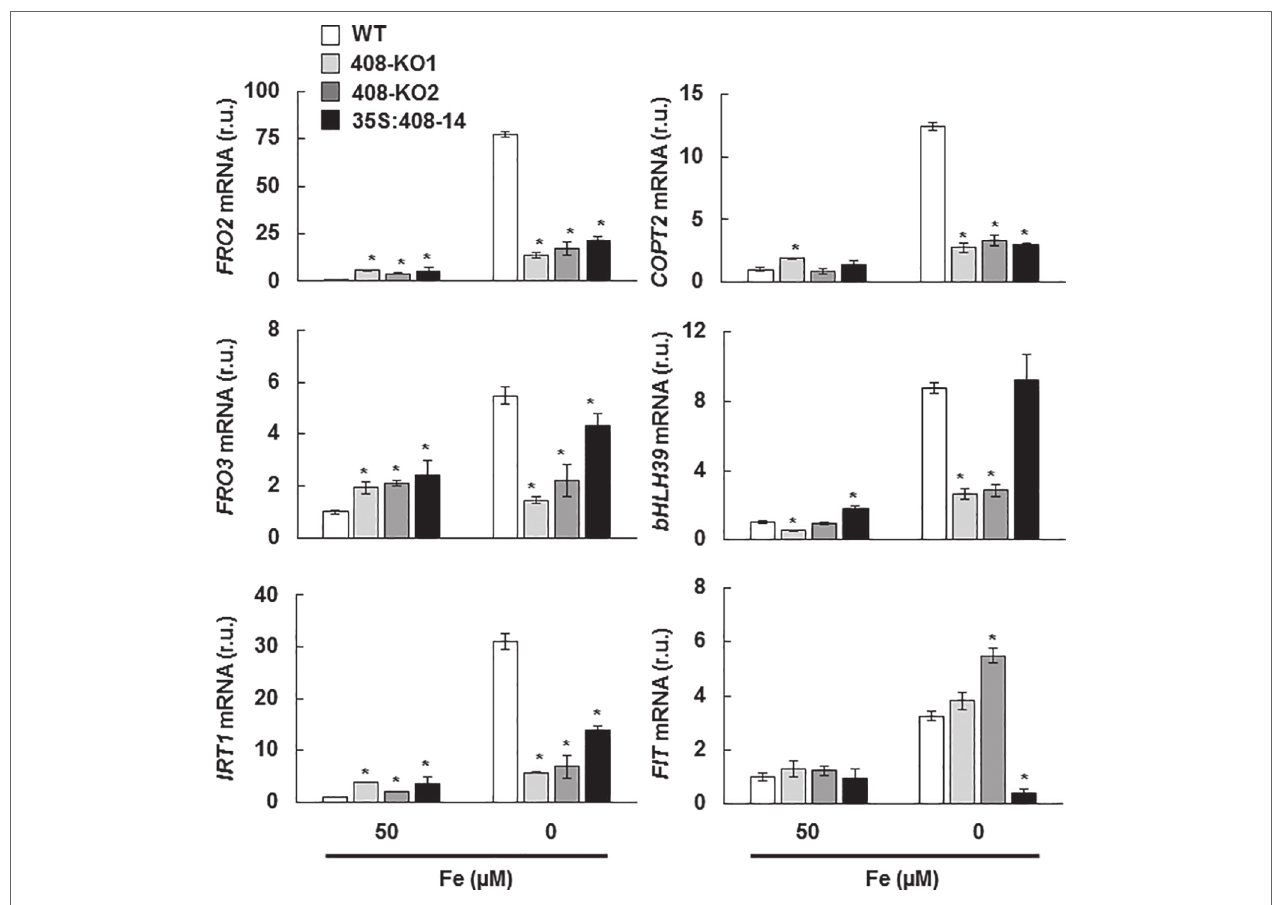
FIGURE 5 | Expression of the metal homeostasis-related genes under iron deficiency in the seedlings with altered miR408 expression. FRO2, FRO3, IRT1, COPT2, bHLH39 , and FIT1 relative expression . The 15-day-old wild-type (WT), 408-KO1, 408-KO2, and 35S:408-14 seedlings grown in 1/2 MS medium containing 50 and 0 μ M Fe citrate. Total RNA was extracted and analyzed by RT-qPCR with specific oligonucleotides for FRO2, FRO3, IRT1, COPT2, bHLH39 , and FIT1. The UBIQUITIN10 gene was used for data normalization and the expression is shown in relative units (r.u.). Values correspond to the arithmetic means (2 −∆∆Ct ) ± standard deviation of at least three biological replicates ( n ≥ 25). Asterisks indicate significant differences for the same group of samples versus the WT line ( p < 0.05) based on the pair-wise fixed reallocation randomization